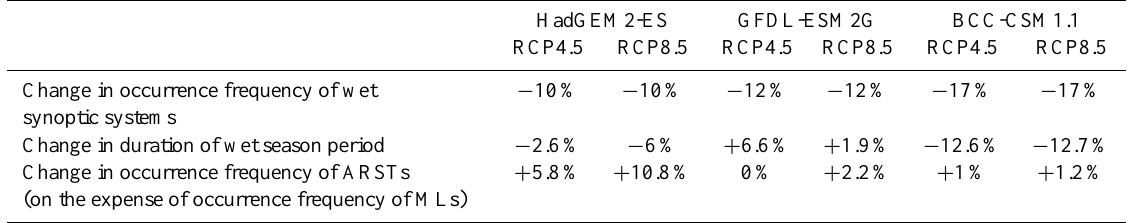
Table 3. Projected changes in regional synoptic system frequency derived from three GCMs comparing the beginning and the middle of the 21st century for the northern Israeli coastline (after Peleg et al.,